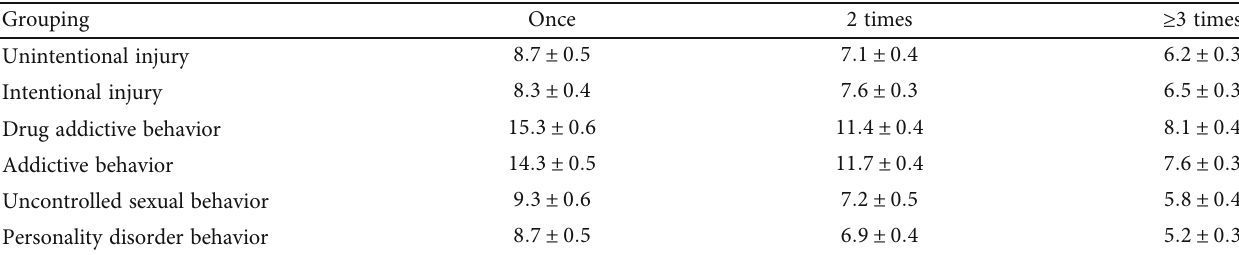
Table 3: Recurrence times of di ff erent AHRB in 3 years after